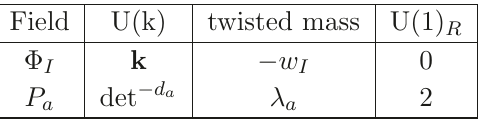
Table 2 . Matter content of the U( k ) GLSM for the complete intersection variety X 2 in G ( k, n ). Here I = 1 , . . . , n and a = 1 , . . . , r .